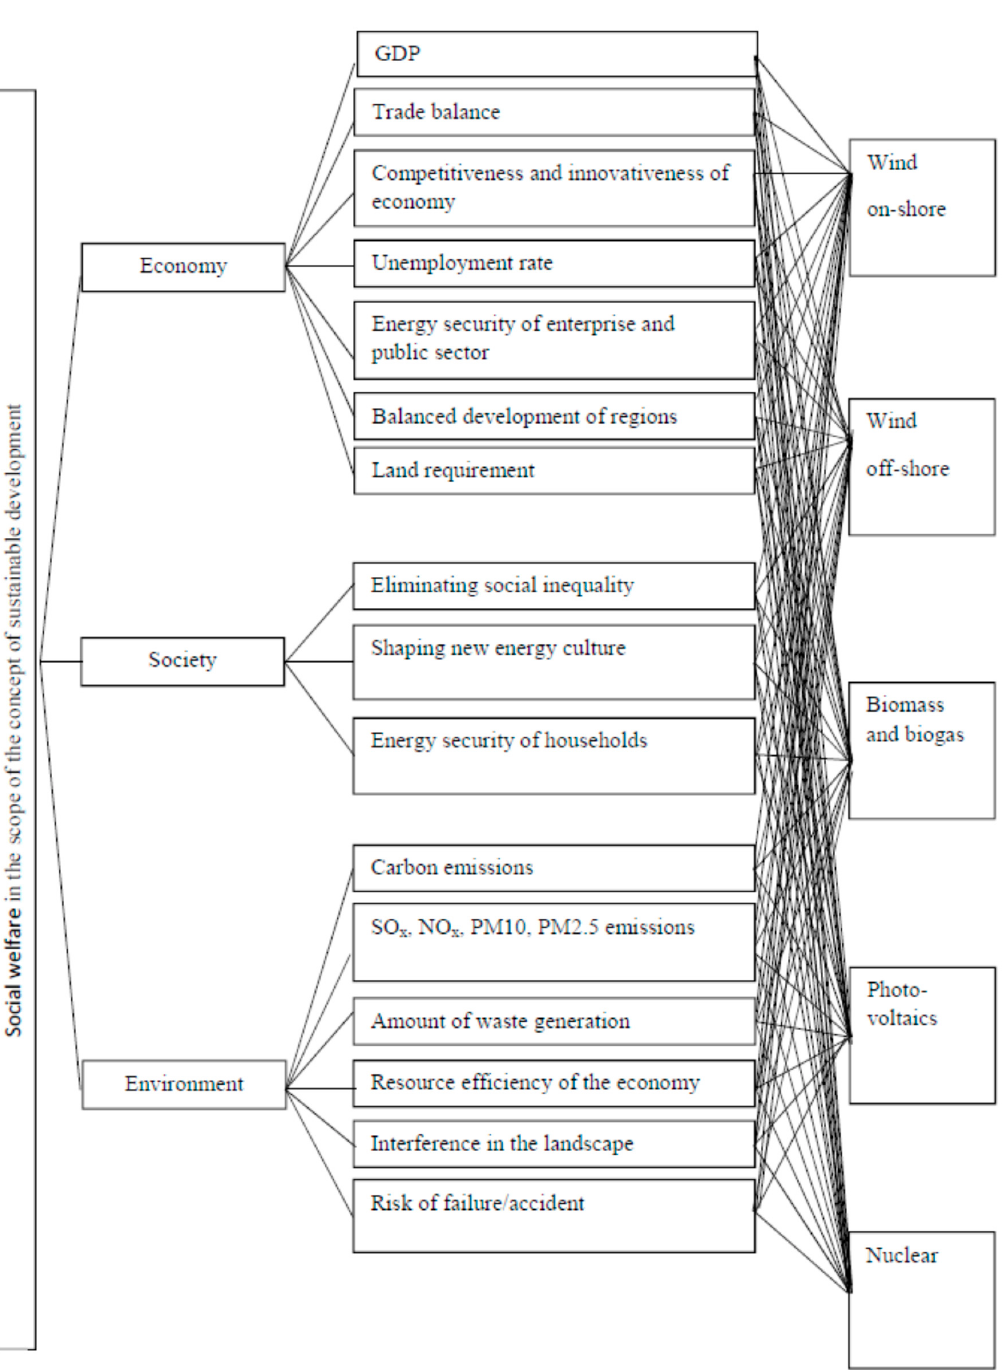
The consistency coefficient was calculated for aggregated pairwise comparison matrix. In the case of pairwise comparison matrices for sub-criteria, the consistency ratios were less than 6%, while for matrix for main criteria CR slightly exceeded the arbitrarily set value of 10%. Exceeding CR maximum value was so small that it was considered that the matrix was consistent.